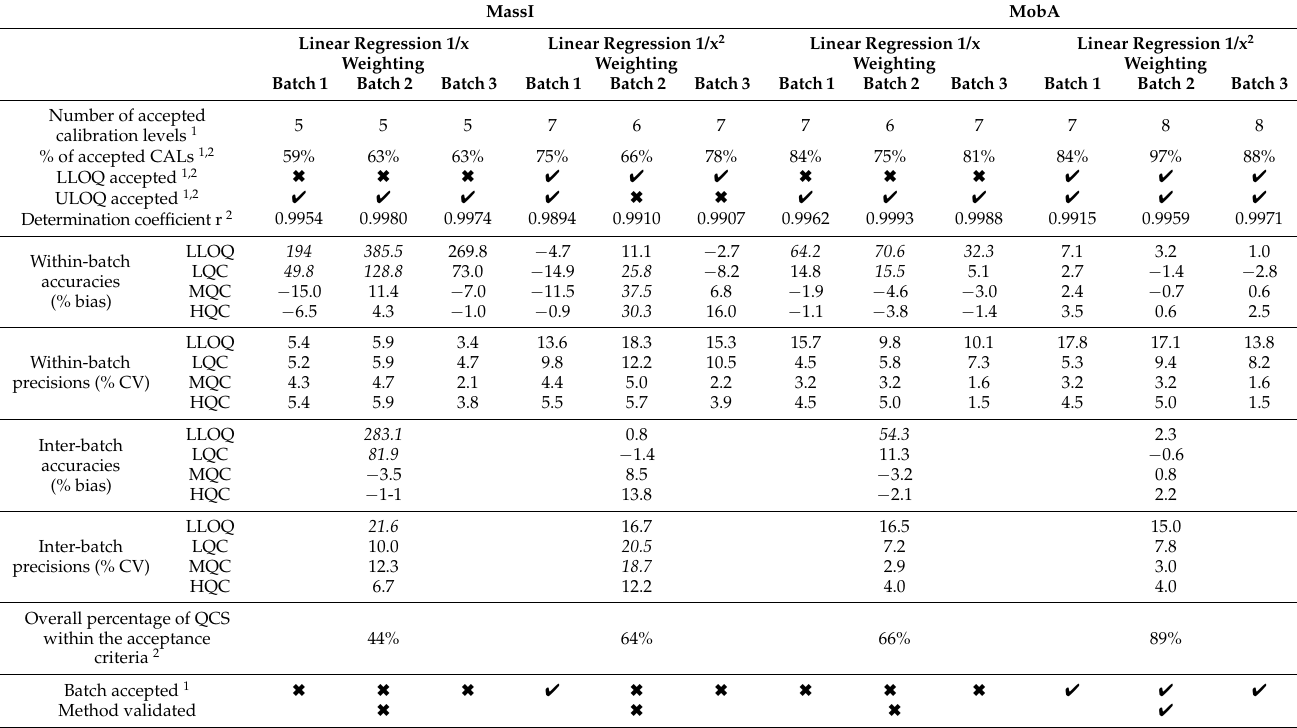
Table 1. Summary of the accuracy and precision validation results obtained for the osimertinib matrix-assisted laser desorption/ionization—ion mobility—tandem mass spectrometry (MALDI-IM-MS/MS) quantification assay using two methods for data extraction: MassI (i.e., the use of extracted mass signal intensities) and MobA (i.e., use of the area-under- the-curve of the extracted mobility peaks). In addition, two weighting approaches were employed for linear regression computation: 1/x and 1/x 2 . MassI MobA Linear Regression 1/x Linear Regression 1/x Linear Regression 1/x 2 Linear Regression 1/x 2 Weighting Weighting Weighting Weighting Batch1